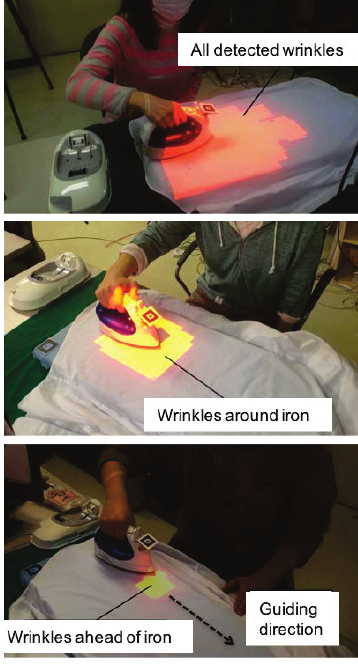
Figure 3. Three types of ROIs enhancement through a projector. Top: full ROIs enhancement, Center: around iron enhancement, Bottom: iron leading enhancement.